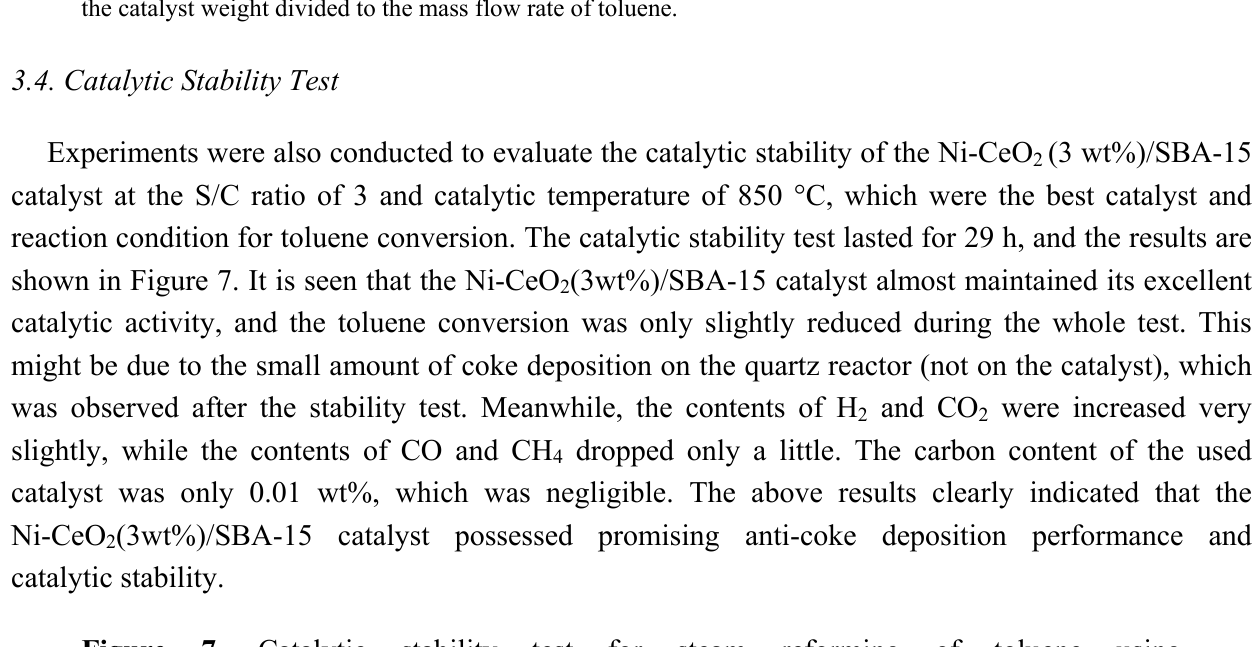
content; ( ∆ ) CO content; 2